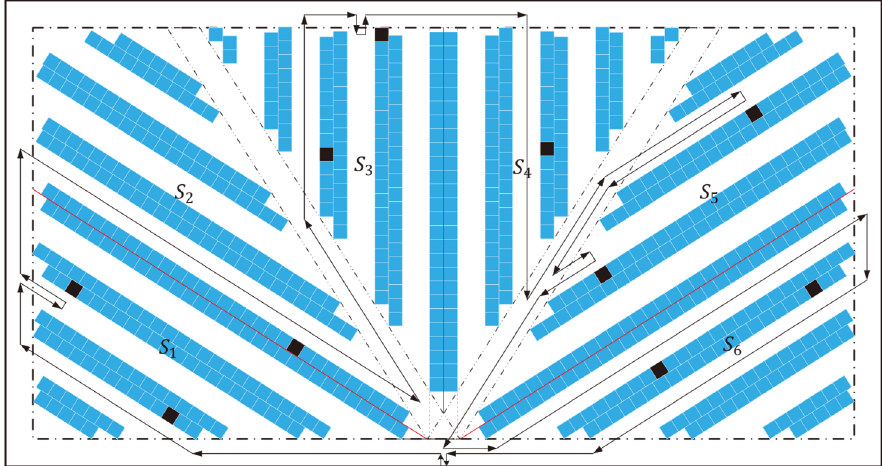
Figure 4. The composite strategy in the leaf layout warehouse.